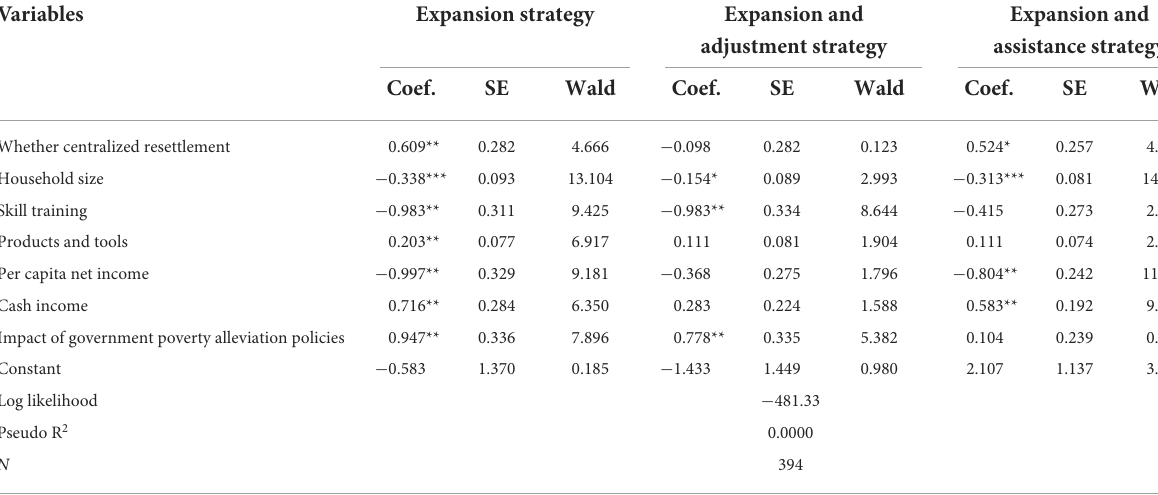
TABLE 4 The impact of resettlement approaches on the choice of adaptation